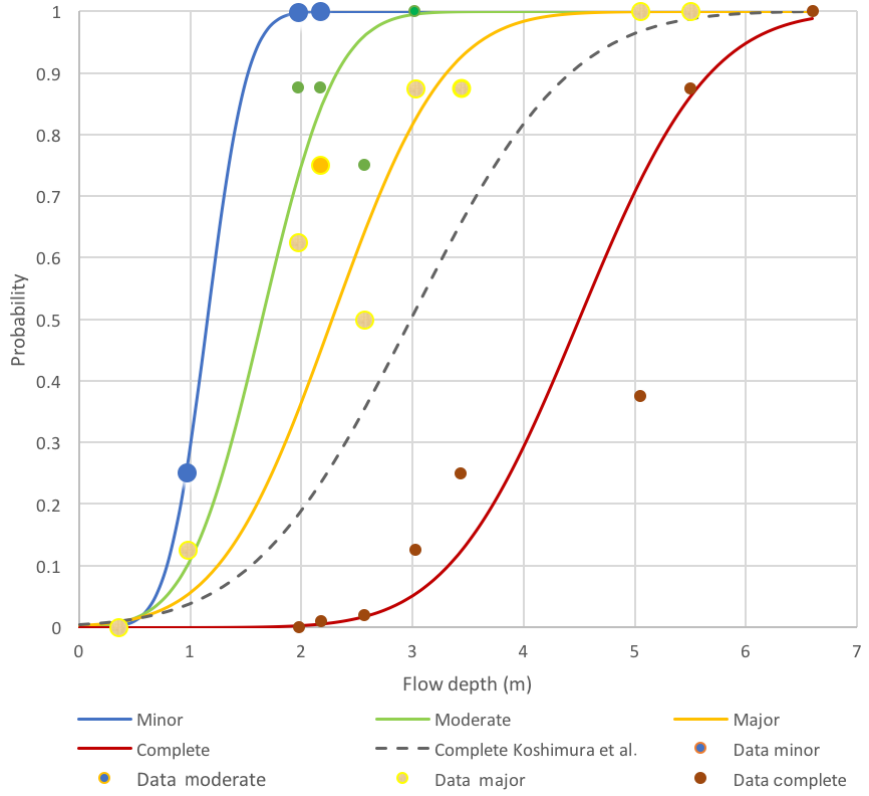
Figure 14. Fragility curves of confined-masonry-type houses, as impacts of the 2018 Mount Anak Krakatau volcanogenic tsunami. Dashed line represents a complete damage fragility curve produced by Koshimura et al.